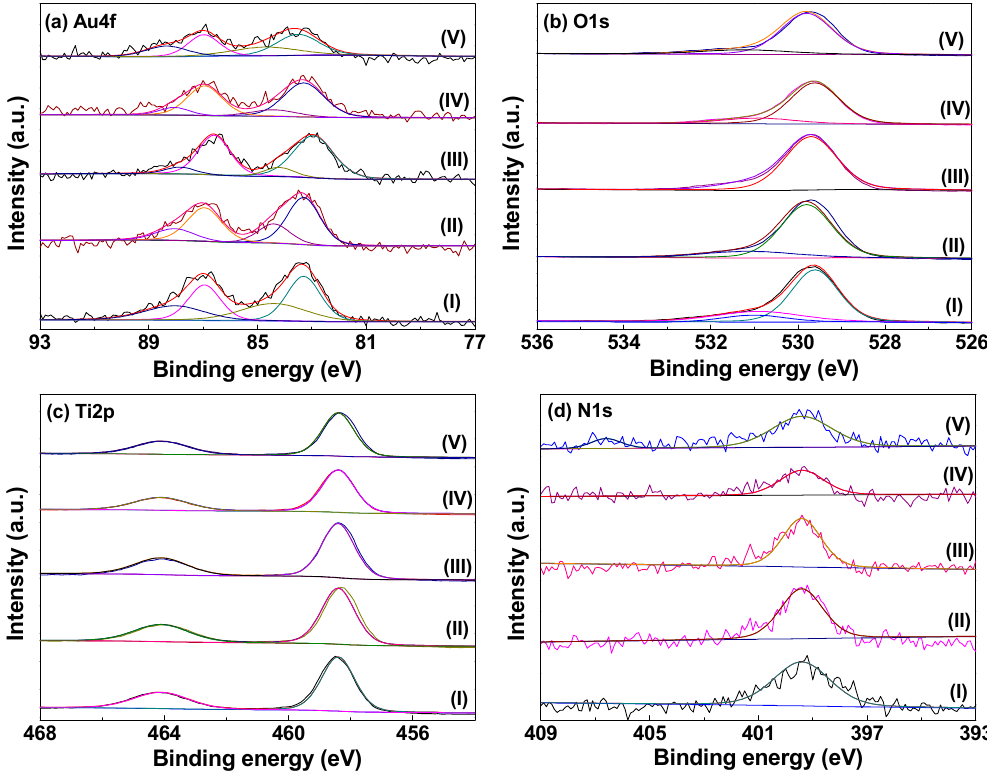
Figure 5. X-ray spectroscopy (XPS) spectra of ( a ) Au4f; ( b ) O1s; ( c ) Ti2p; and ( d ) N1s in (I) Au/P25-As; (II) Au/P25-O 2 P; (III) Au/P25-H 2 P; (IV) Au/P25-ArP; and (V) Au/P25-AirP.